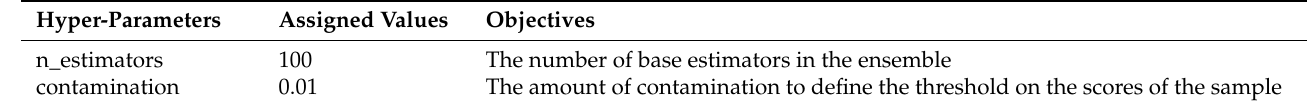
Figure 7. Flow-chart of training individual AI models from heterogeneous database. Table 3. Parameters assigned in training isolation forest